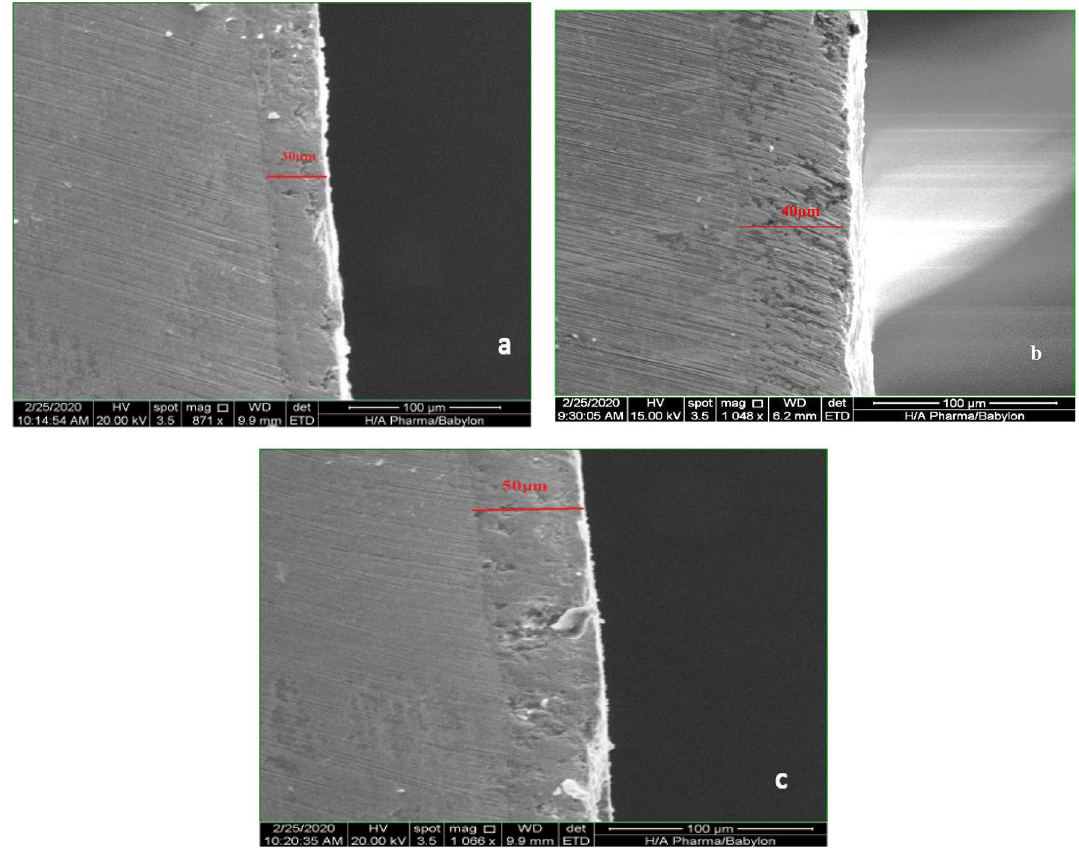
Figure 16. SEM images for coating thickness. ( a ) 30 µm, ( b ) 40 µm, ( c ) 50 µm 21 .